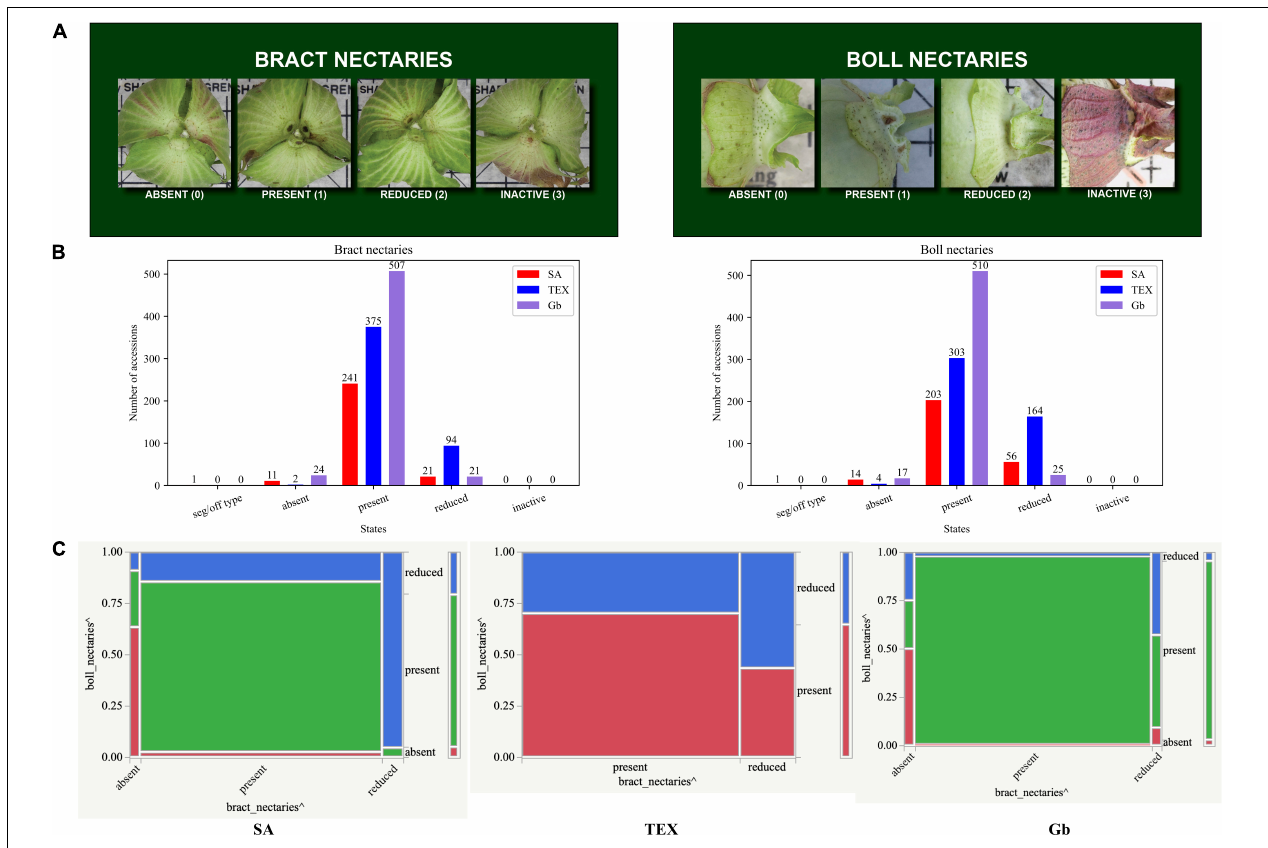
FIGURE 7 | Information related to boll and bract nectaries in SA, TEX, and Gb. The results independently showed a significant association among the three groups (FDR adjusted P -values – P < 0.01). (A) The photos show the rating scale for bract and boll nectaries. (B) The two nectary descriptors show a similar distribution of state. (States with ≤ 5 observations and the seg/off type category were removed prior to bivariate association analysis). (C) Mosaic plots from contingency analysis show the relationship among descriptor states for each group evaluated. See Figure 5 for details on the mosaic plot interpretation.